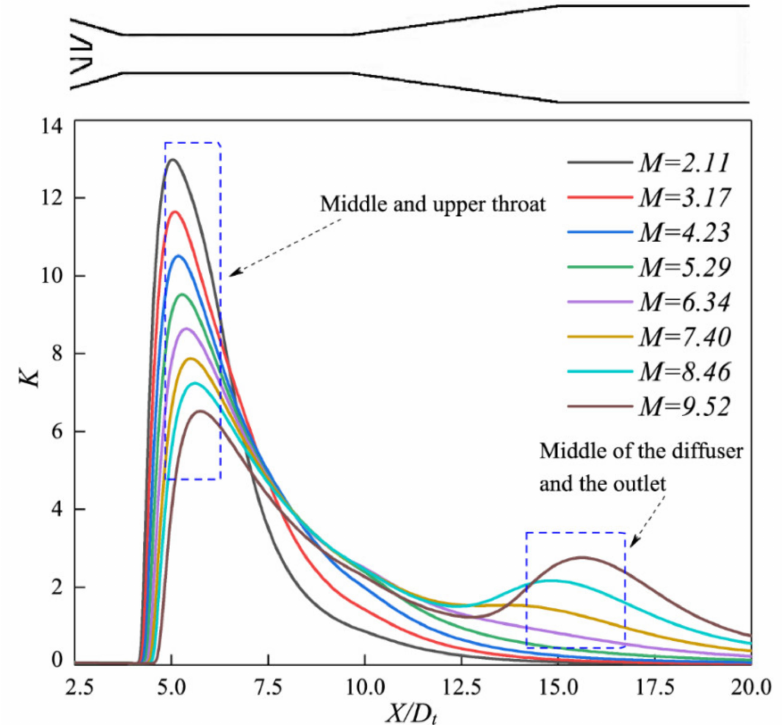
Figure 7. Turbulent kinetic energy distribution of the shaft axis from nozzle inlet to exit ( M = 2.11, 3.17, 4.23, 5.29, 6.34, 7.40, 8.46,